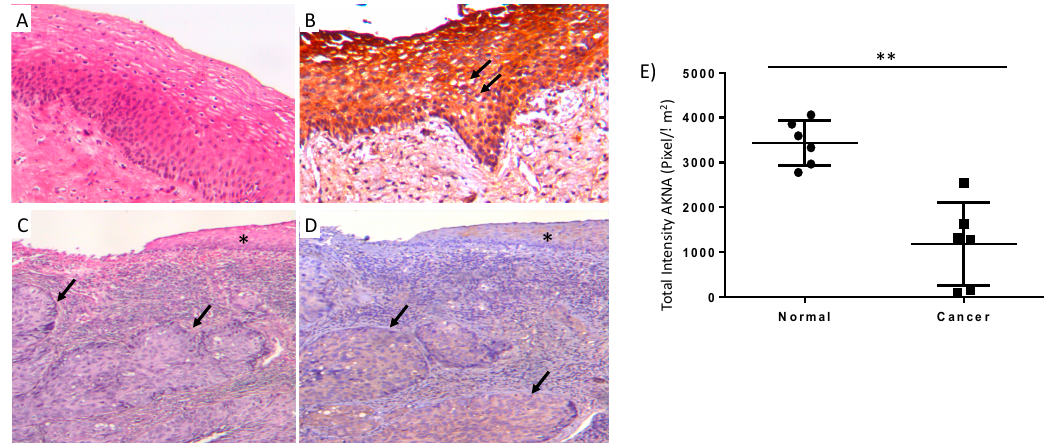
Figure 1. Representative micrographs of conventional histology and immunohistochemistry to detect AKNA in normal and neoplastic cervical epithelium. ( A ) Normal histological appearance of uterine cervix, showing squamous stratified epithelium supported by connective tissue. ( B ) Normal epithelium showing strong AKNA immunostaining. Arrows indicate koilocytes where AKNA staining is absent. ( C ) Intense cervicitis with small fragment of epithelium (asterisk) and large nodules of neoplastic cells in subjacent connective tissue that correspond to infiltrating areas of mild differentiated squamous cell carcinoma (arrows). ( D ) Conserved epithelium (asterisk) and neoplastic nodules (arrows) show slight AKNA immunostaining (panels A and B 200× magnification, panels C and D 100× magnification). ( E ) Digital pathology study confirmed AKNA reduced levels in cancer cases ( n = 6) compared to normal epithelia ( n = 6) (** p <